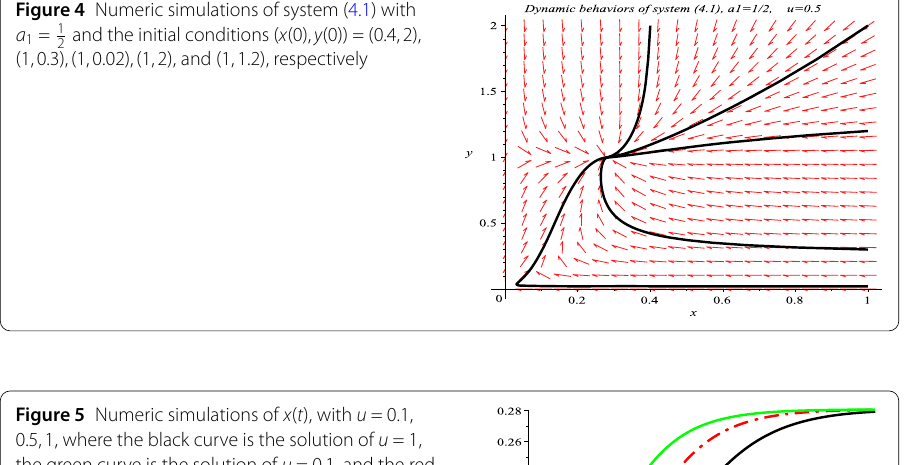
Figure 4 Numeric simulations of system (4.1) with a